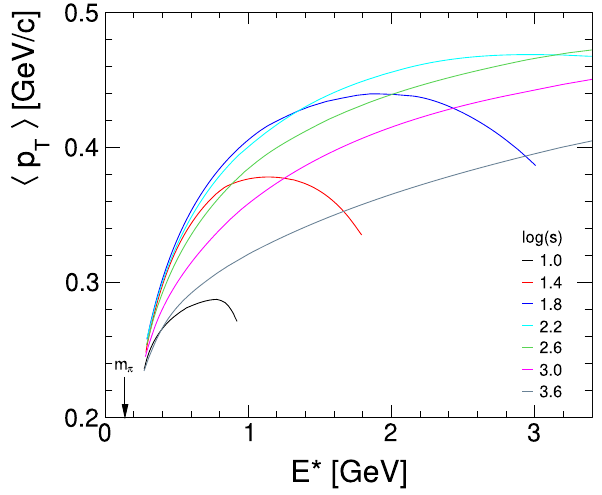
Fig. 180 (cid:4) p T (cid:5) of π − as a function of cms energy E ∗ for seven inter- √ s from 3.2 to 63 action energies